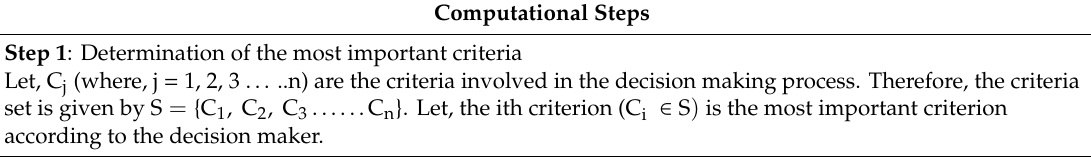
Table 5. Level-based weight assessment (LBWA)